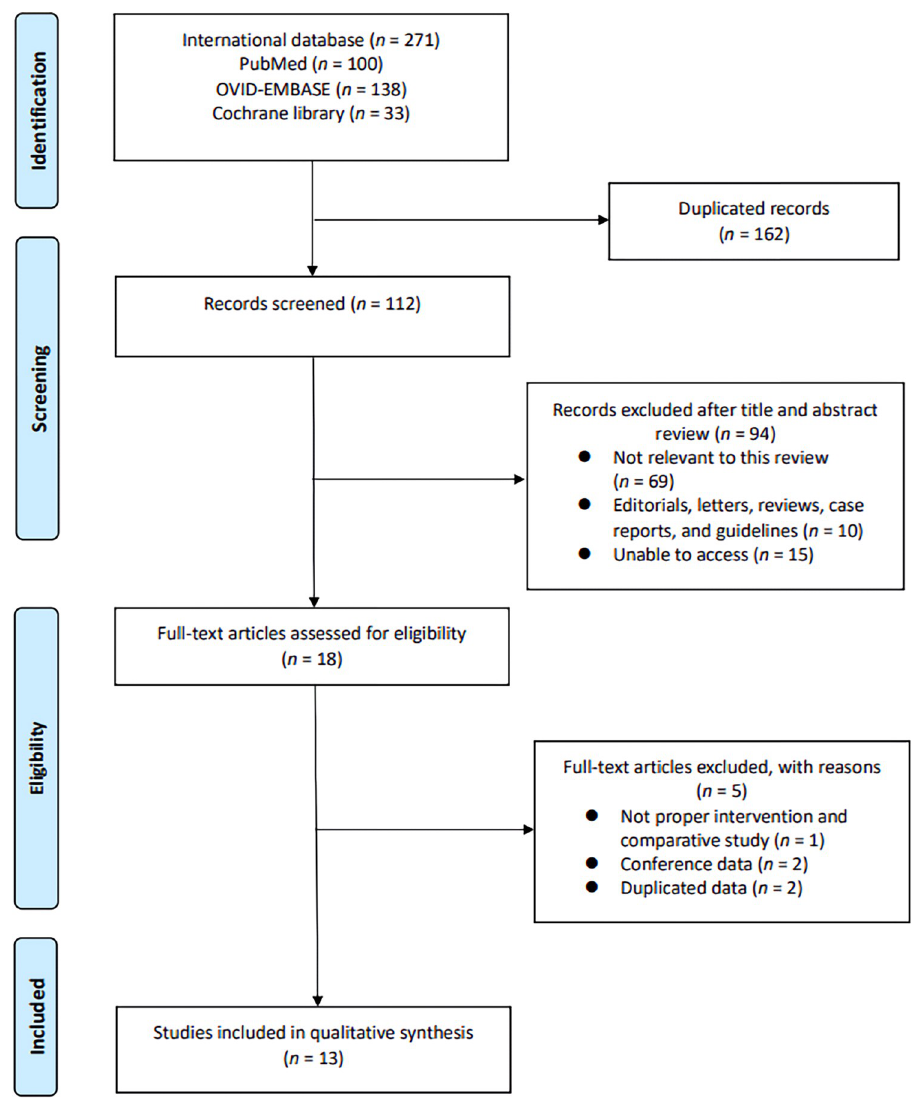
Fig 1. Study selection flowchart according to Preferred Reporting Items for Systematic Reviews and Meta-analysis